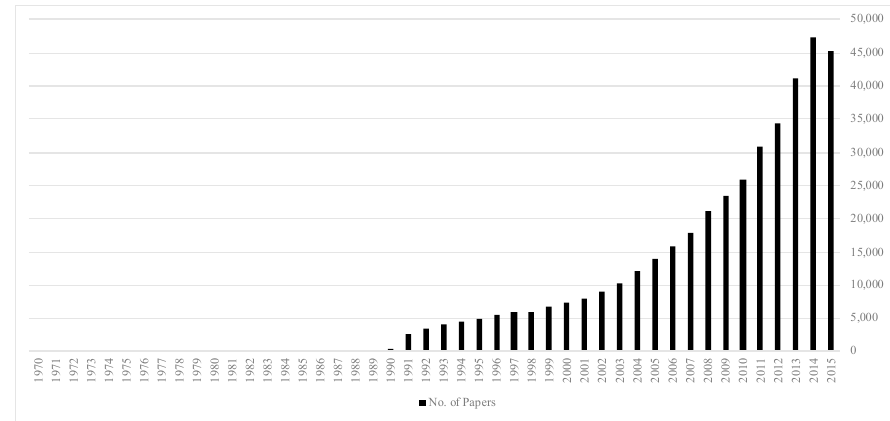
Figure 4. Number of publications each year ( x -axis: year of publication, y -axis: number of publications).